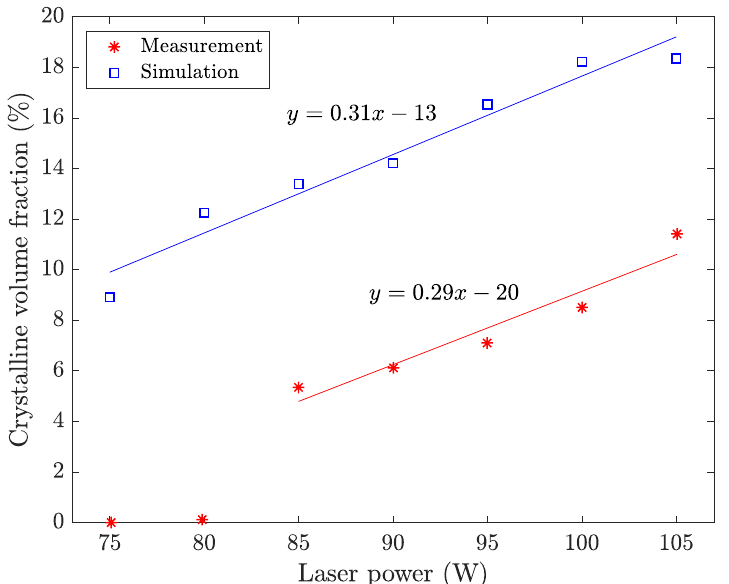
Figure 5. Simulated and measured crystalline volume fraction [15] with respect to laser power. Hatch spacing and hatch length are constant at 100 µ m and 5 mm, respectively. The R 2 value for the fitted lines are 0.92 and 0.96 for the measurement and simulation, respectively. The experimental values for the 75 and 80 W samples were omitted from the fitting procedure as local fractions of crystals were apparent from microscopy analysis [15].